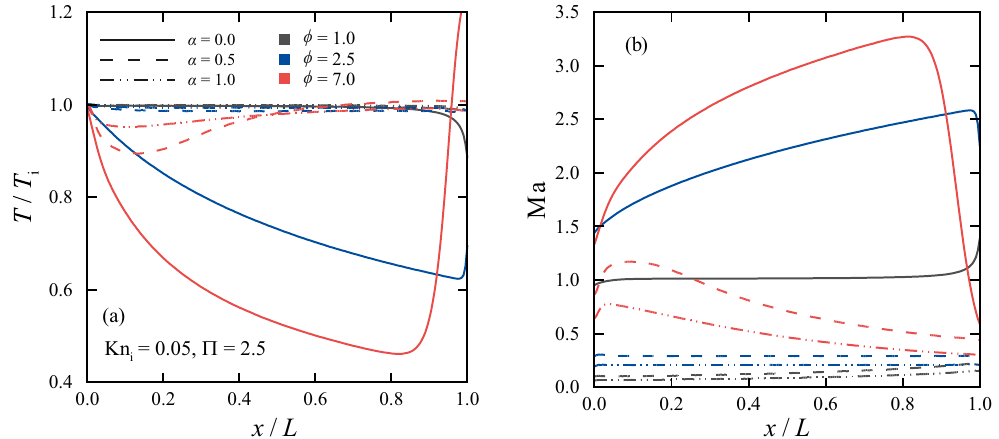
Figure 10. The effect of the tangential accommodation coefficient α on the profiles of ( a ) gas tempera- ture and ( b ) Mach number along the microchannel centreline ( Π = 2.5 and Kn i = 0.05). The inlet temperature ( T i ) is used to non-dimensionalise the predicted temperatures.